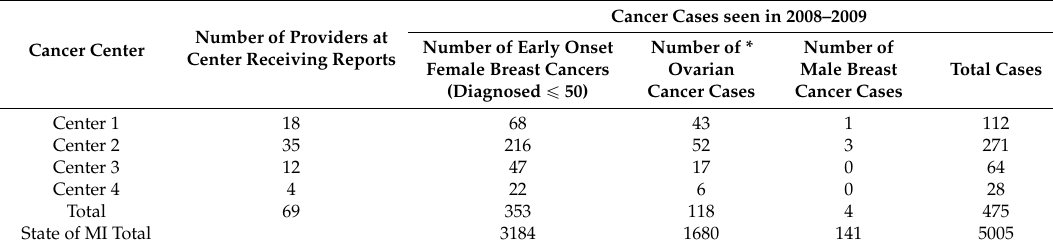
Table 1. Number of cases at risk for HBOC per center,